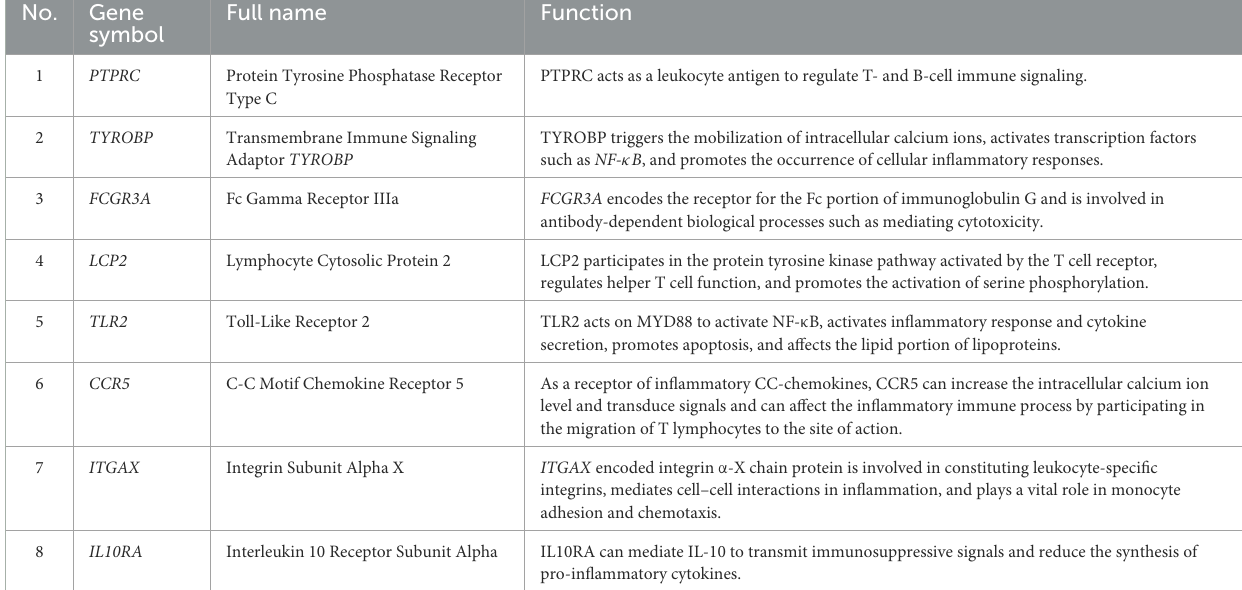
TABLE 1 Specifics and functions of hub genes.